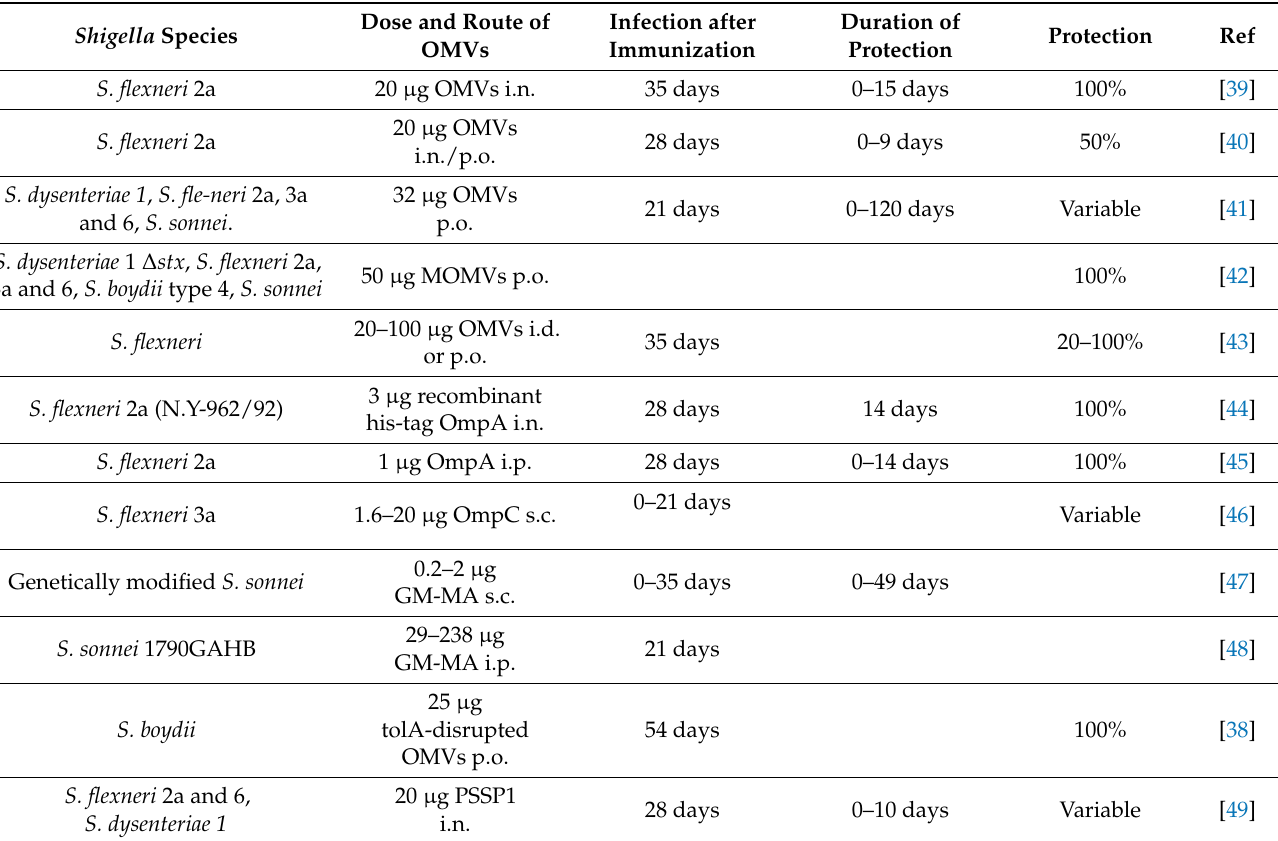
Table 1. Evaluations of immunological response triggered by Shigella OMVs in infection models. Dose and Route of Infection after Duration of OMVs Immunization Protection